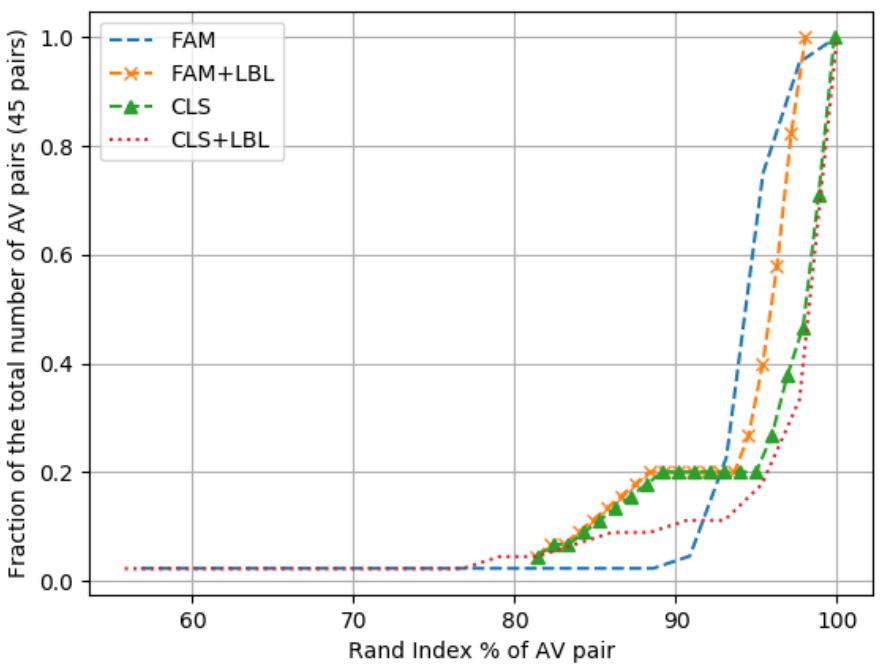
Figure 5. FAM/CLS Commonality: AVCLASS2 detects common Family (FAM curve) or common Class (CLS curve) in labels from both engines. FAM/CLS + LBL: AVCLASS2 families are com- plemented with the complete label if no FAM/CLS can be detected in both engines. AV engines Rand_Index values are lower whenever labels (LBL) are